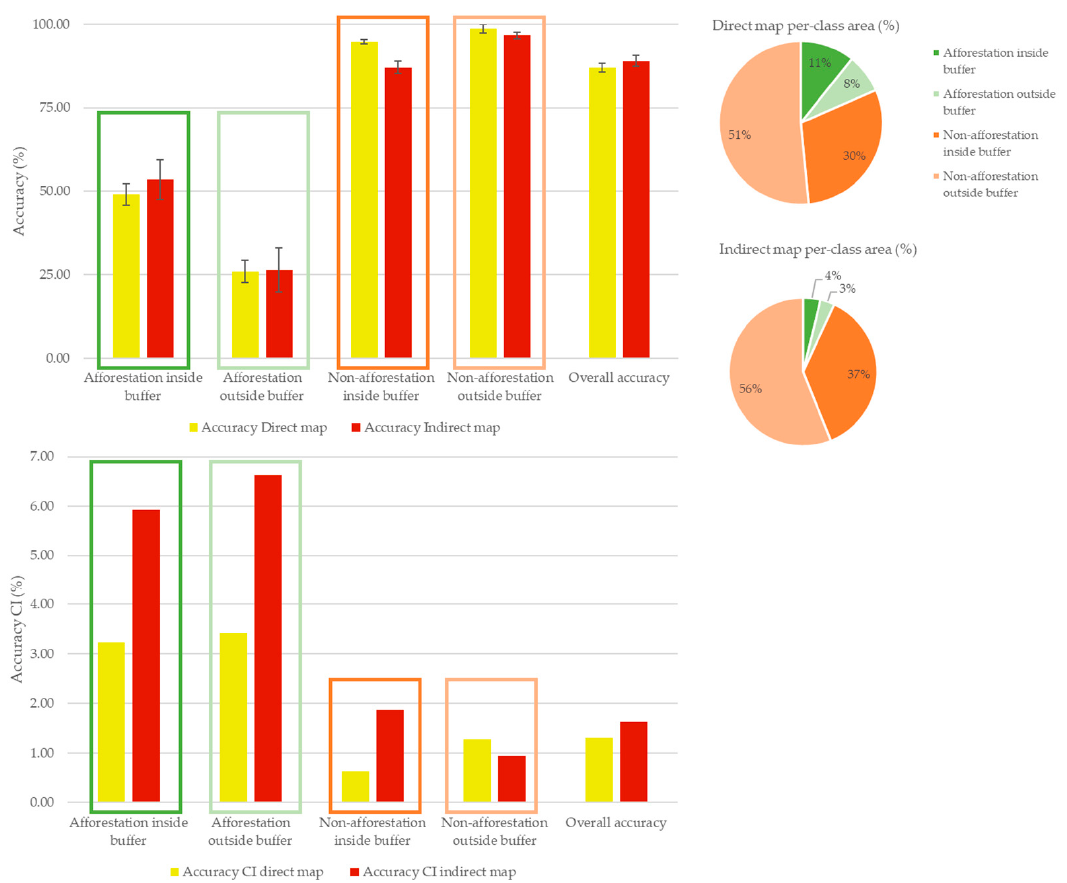
Figure 4. Top : direct and indirect map overall accuracy and class accuracy estimates and confidence intervals comparisons. Bottom : a focus on confidence intervals. The pie charts represent the class area distributions in the direct and indirect maps.